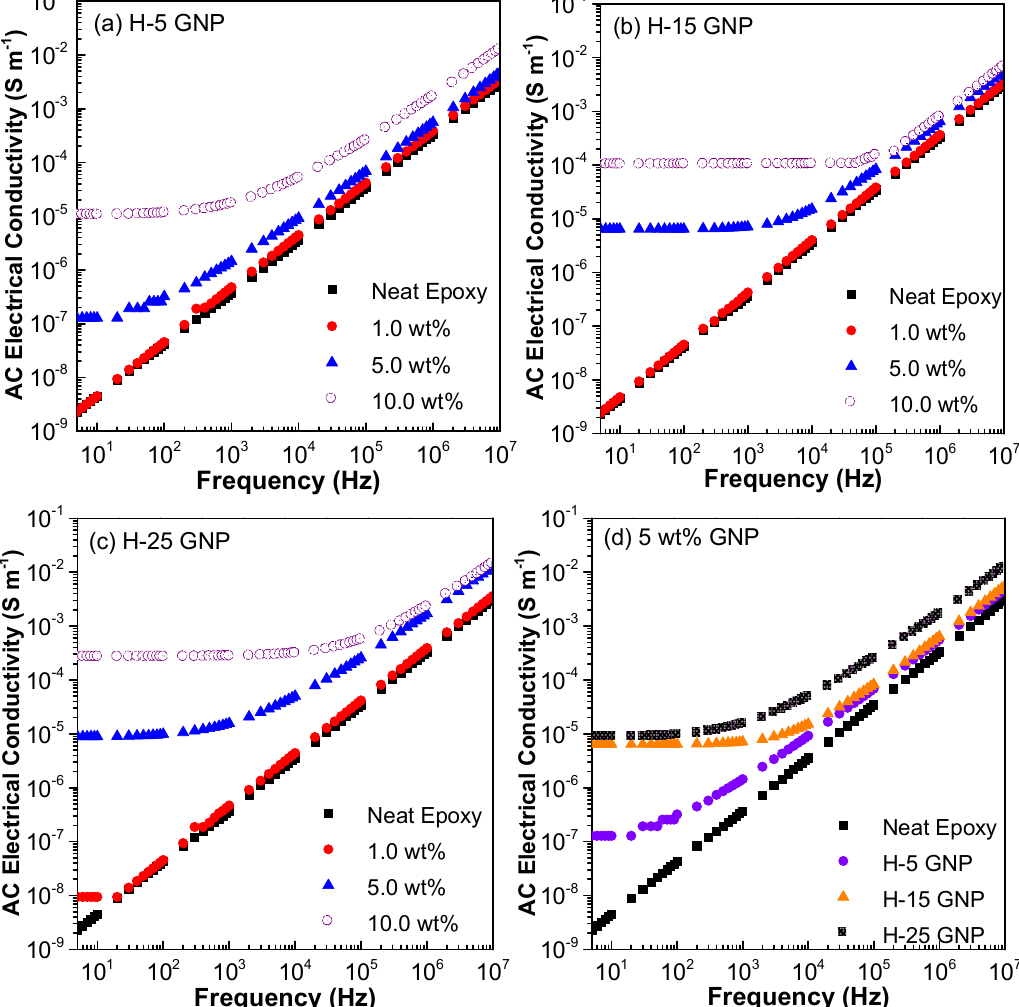
Figure 10. AC electrical conductivity of GNP/epoxy nanocomposites ( a ) GNP H-5; ( b ) GNP H-15; ( c ) GNP H-25; ( d ) f GNP = 5 wt %. ( c ) GNP H-25; ( d ) f GNP = 5 wt